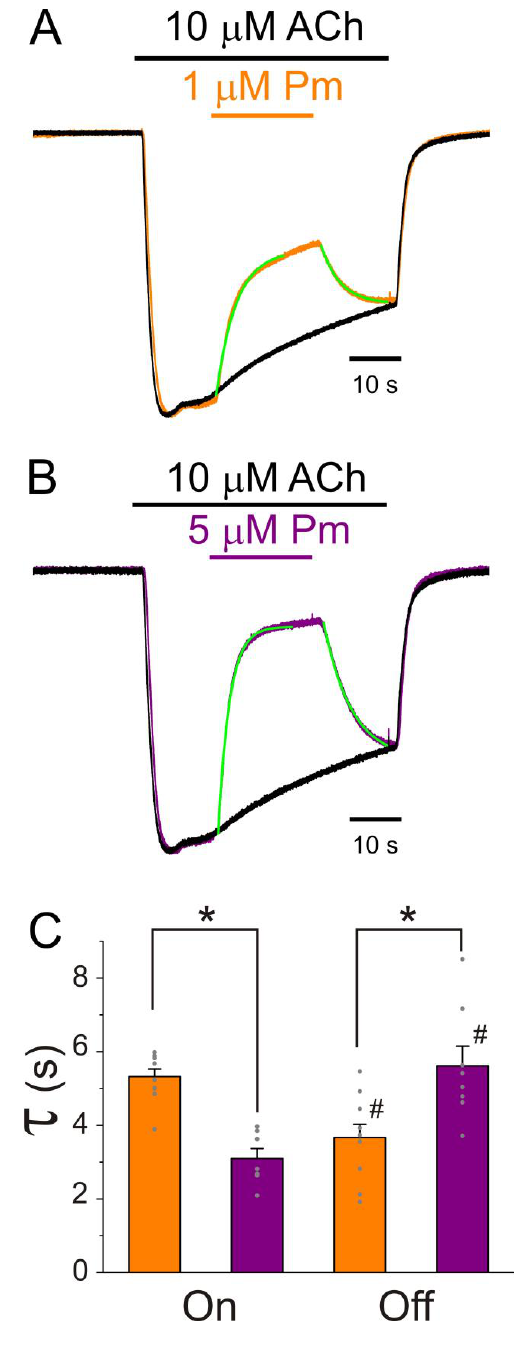
Fig.6 Figure 6. Blockade of open nAChRs by Pm. ( A , B ) Superimposed I ACh s elicited by 50 s pulses of 10 µ M ACh either alone (black recordings) or together with 1 ( A ) or 5 µ M ( B ) Pm, applied at the I ACh plateau. I p s were normalized to the same amplitude to facilitate the kinetics comparisons. The kinetics of I ACh inhibition and its recovery from blockade followed exponential functions (green traces ( A , B )). ( C ) Column graph of the τ values found for I ACh blockade onset (“On” columns) when 1 (orange) or 5 µ M (purple) Pm was co-applied with 10 µ M ACh. The “Off” columns correspond to the kinetics of recovery ( τ ) from blockade, following Pm removal (same color code). (*) indicates significant differences of τ values between Pm concentrations for either “On” or “Off” data ( p < 0.05, ANOVA and Bonferroni t -test). (#) denotes differences between “On” and “Off” values for either 1 or 5 µ M Pm ( p < 0.05, paired t -test). Data are for 10 and 8 oocytes ( N = 5) for 1 µ M and 5 µ M Pm,